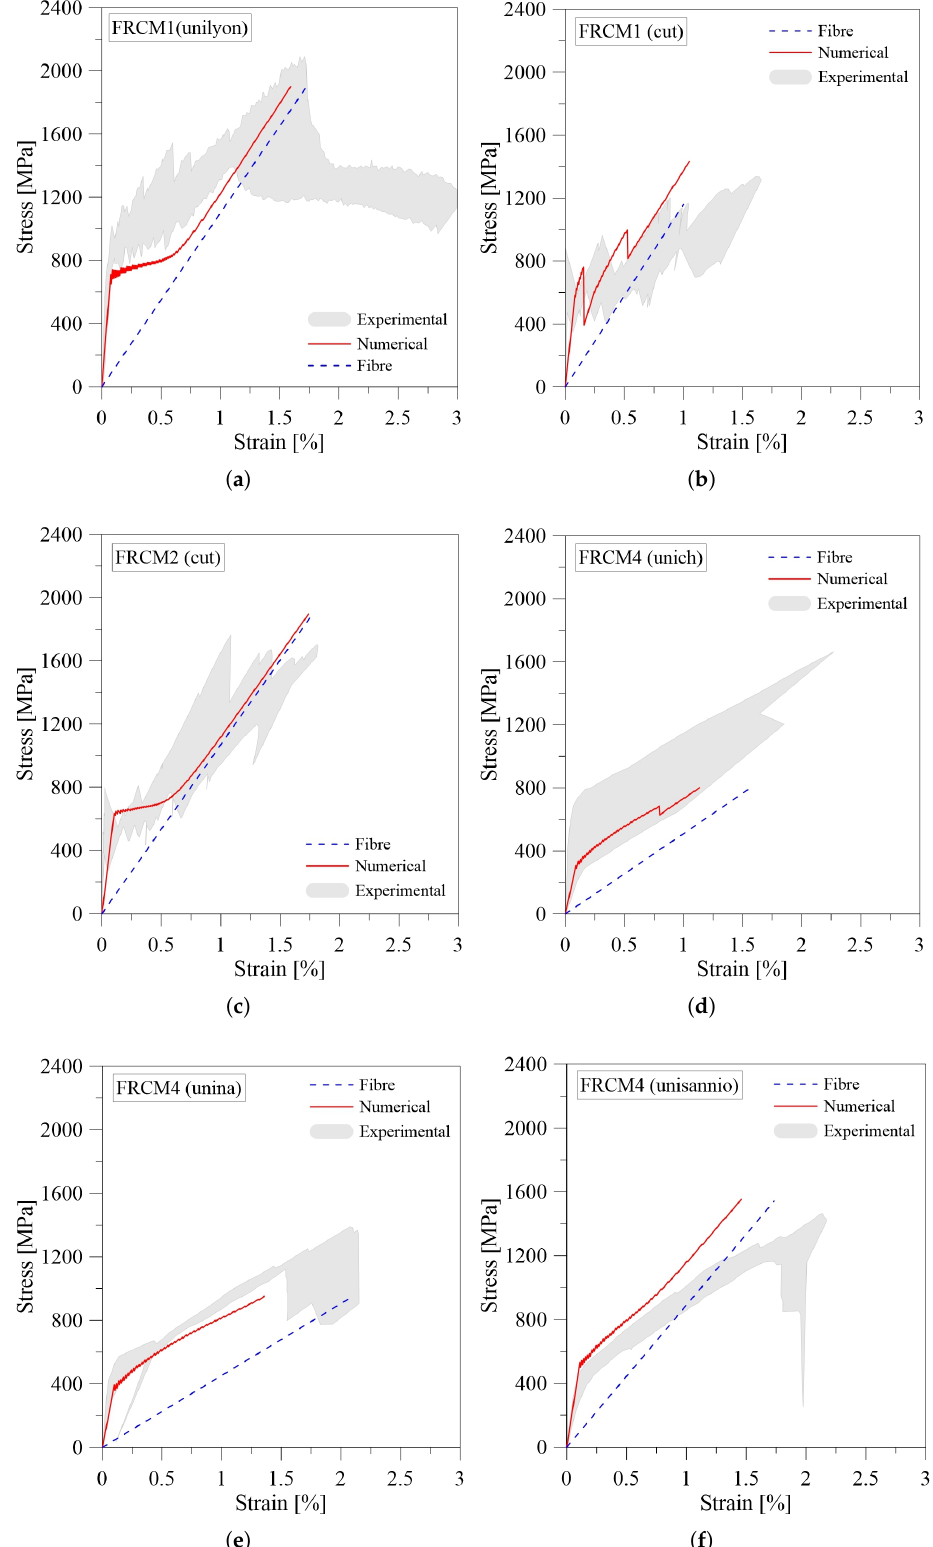
Figure 6. Numerical-experimental comparison of tensile behavior for Basalt-FRCM: ( a ) FRCM1